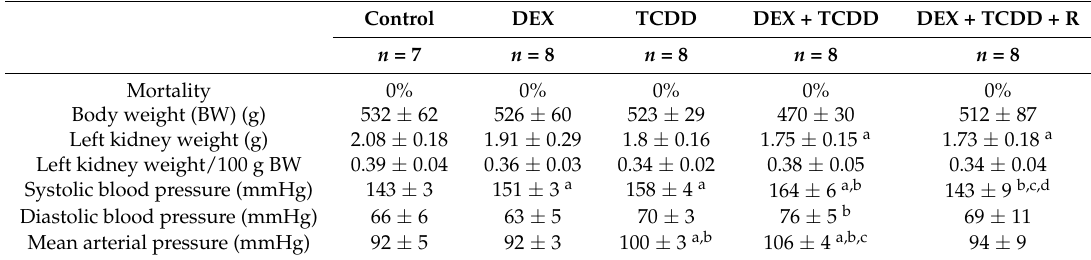
Table 1. Weight and Blood Pressure.